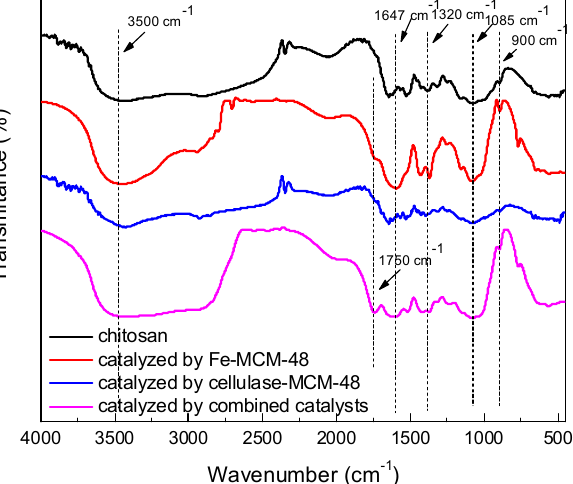
Figure 8. FT-IR spectra of chitosan and its degradation products.